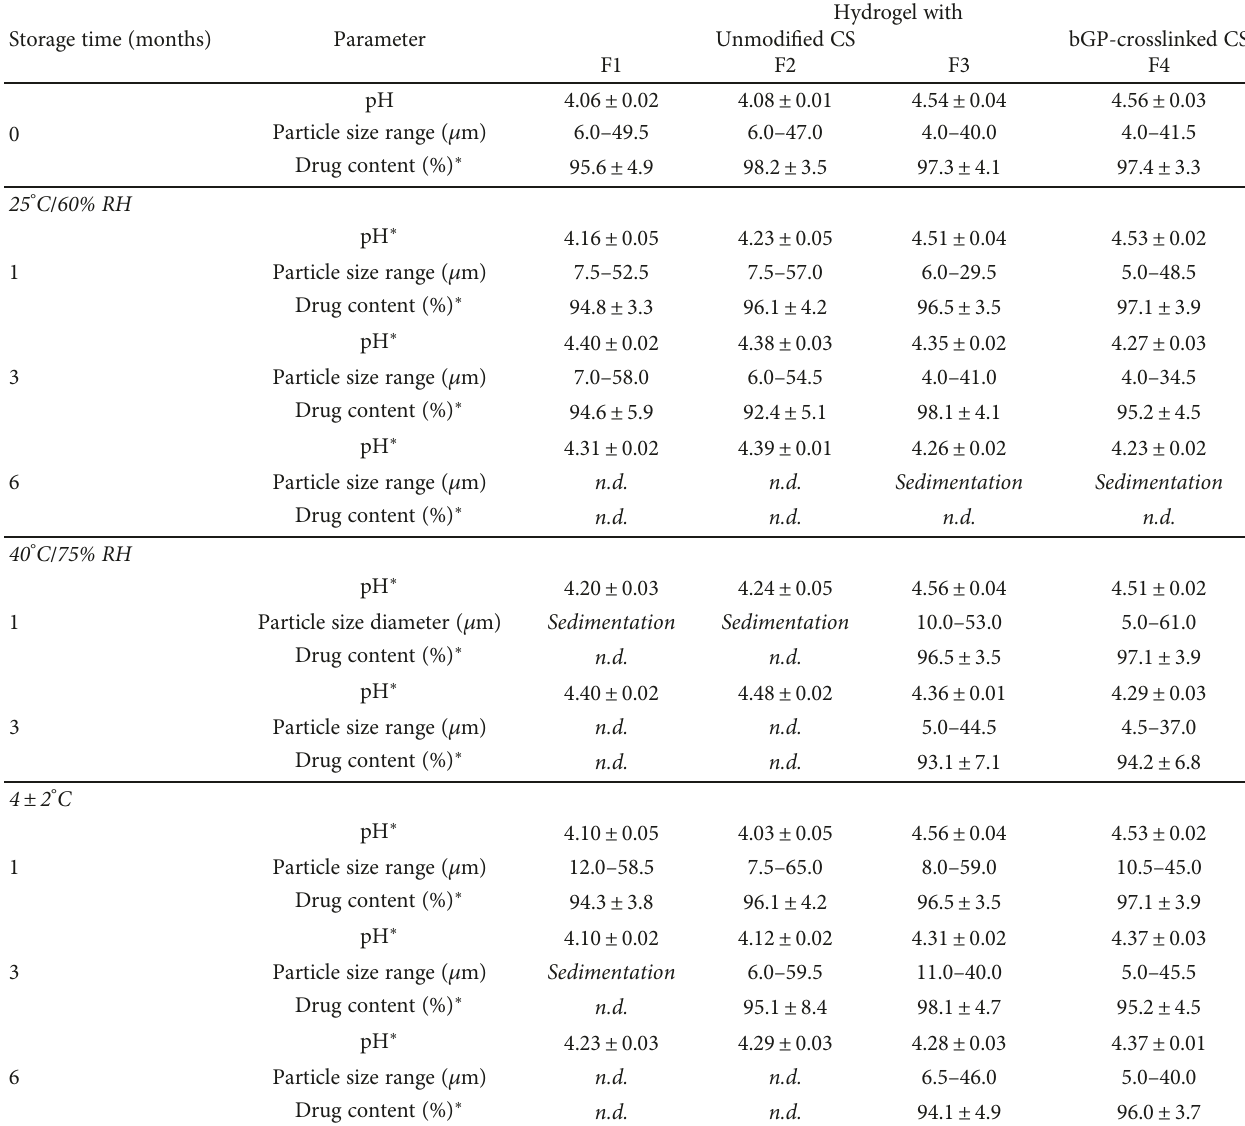
Table 3: Changes in organoleptic properties, clotrimazole content, and drug particle size in hydrogels with unmodi fi ed CS (F1, F2) or with bGP-crosslinked CS (F3, F4) upon storage compared to values obtained to freshly prepared formulations. Storage time